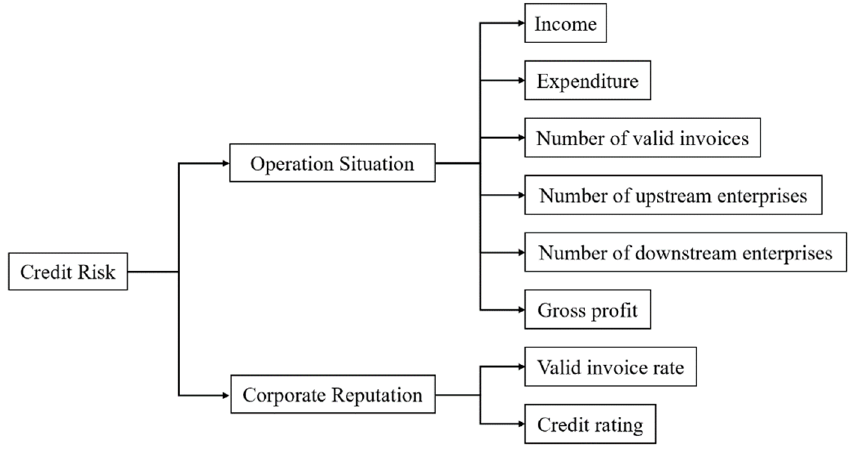
Figure 2. Credit risk evaluation indicators.